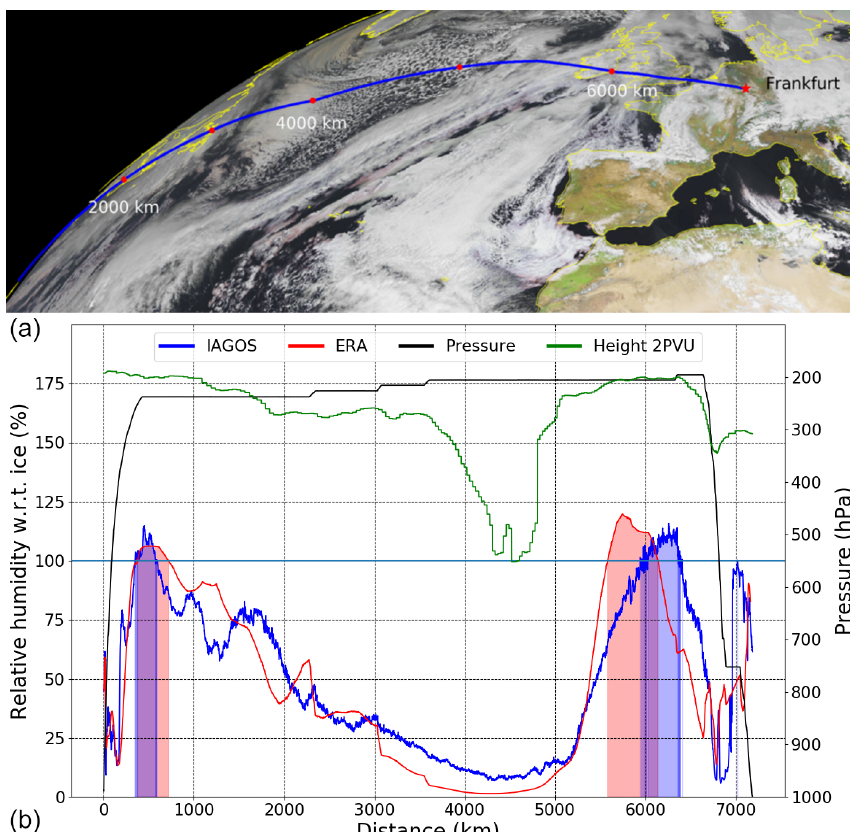
Figure 8. Example of a typical flight from Atlanta (USA) to Frankfurt (Germany) on 7 March 2009. The upper part shows the synoptic situation over the North Atlantic on that day including the flight path. For better orientation, red dots are placed every 1000km. In the lower part, RH i is shown over the distance of the flight for IAGOS (blue) and ERA (red). Shaded areas denote ice supersaturation. The pressure level of the aircraft is shown in black, and the height in hPa of the dynamical tropopause (2PVU) is shown in green. Satellite image: © 2009 EUMETSAT.